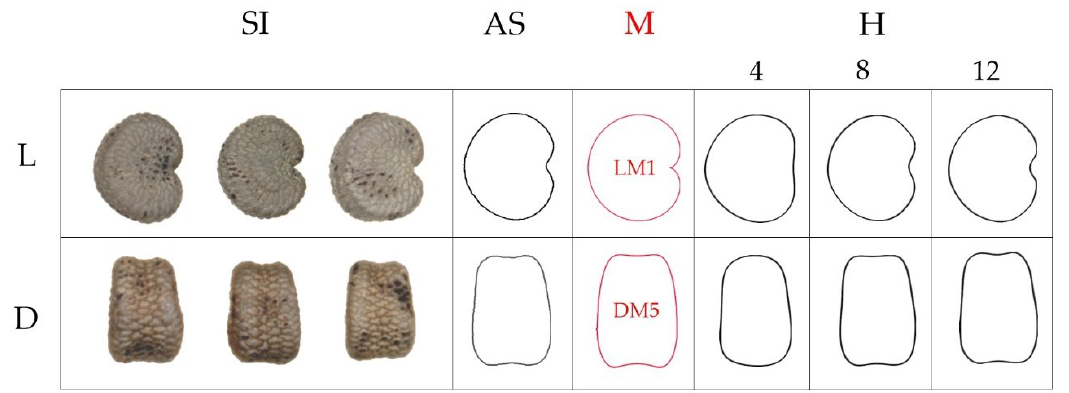
Figure 10. Silhouettes of seeds of S. conica AJ300. L: Lateral view; D: Dorsal view; SI: Seed image; AS: Average silhouette of 20 seeds; M: Models calculated LM1 and DM5; H: Curves obtained by Fourier equations with 4, 8, and 12 harmonics.